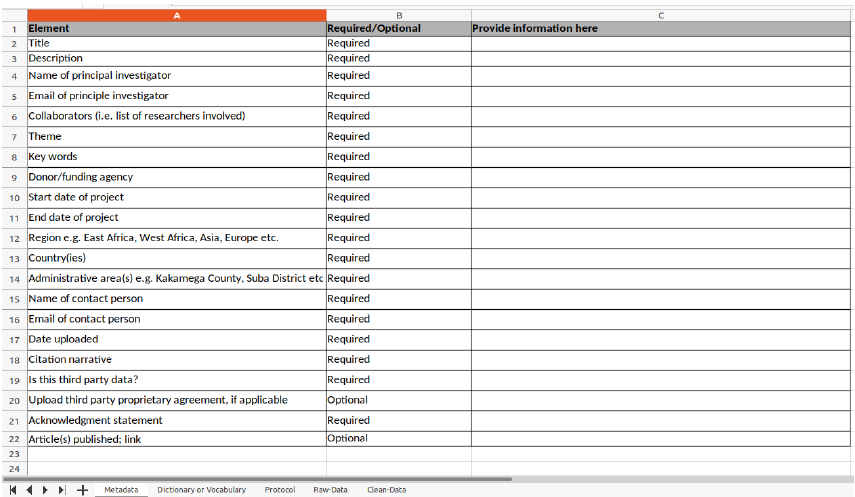
Figure 4. Meta-data template MS Excel